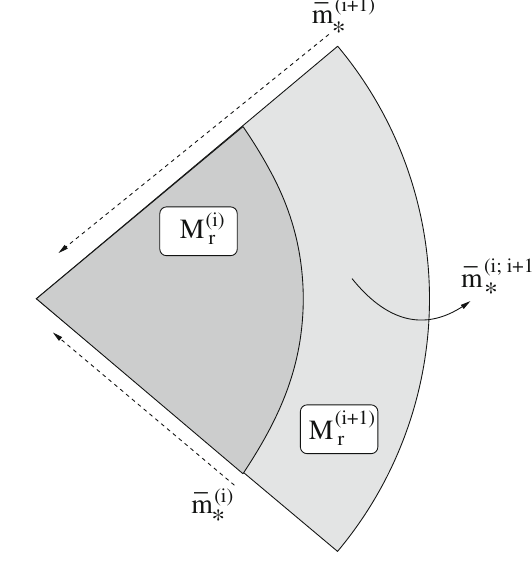
Fig. 27 Average mass in Lagrangian shells from averaged mass in Lagrangian